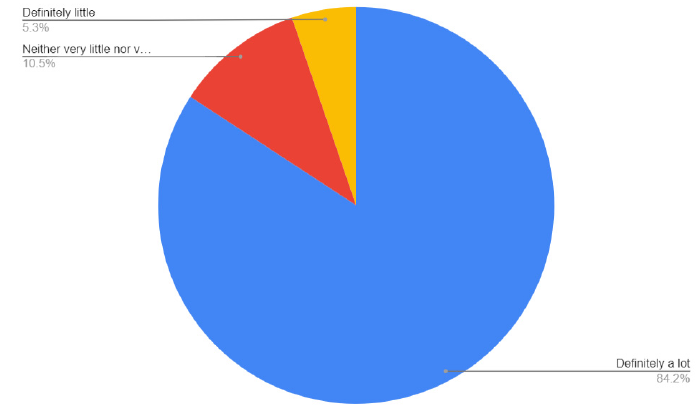
Figure 17. Level of commitment to participating in the MOOC.